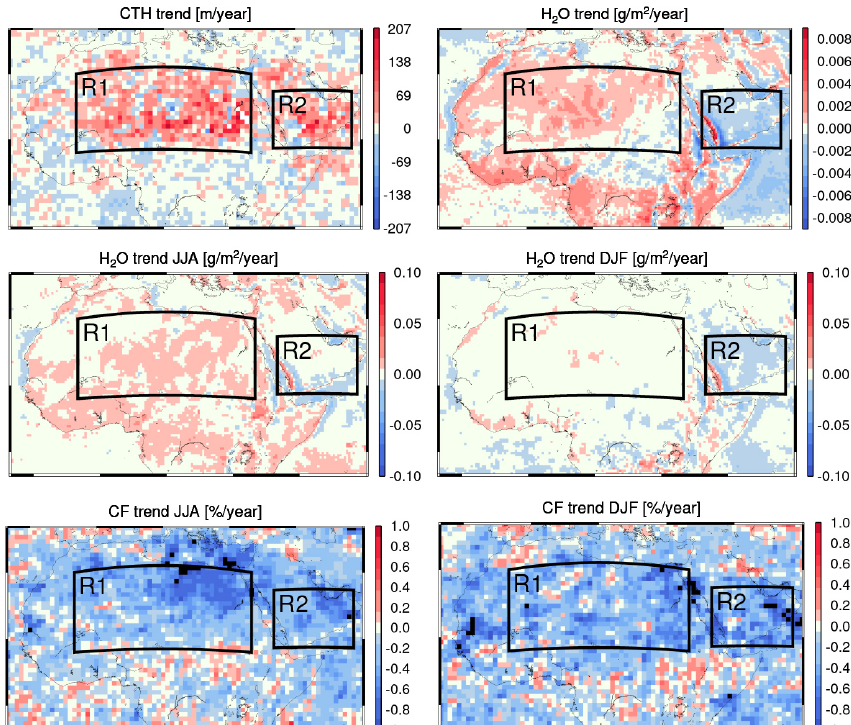
Figure 14. Maps of linear trends over North Africa (R1) and the Arabian Peninsula (R2) for (top left) CTH anomalies and (top right) columnar water vapour anomalies [gm − 2 yr − 1 ]. The latter is subset for (middle left) summer (JJA) and (middle right) winter (DJF) months. Linear trends for CF anomalies are plotted in the bottom row, for summer (left) and winter (right)